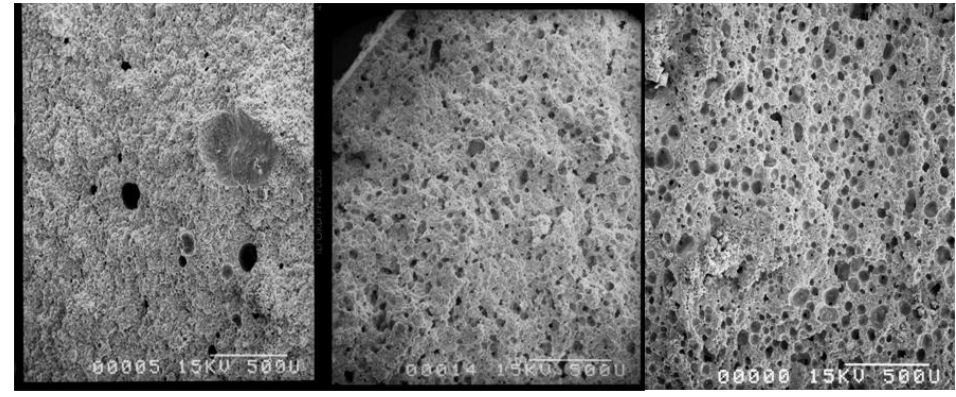
( c ) Cementek + 2% ONS10. Bar = 500  m.